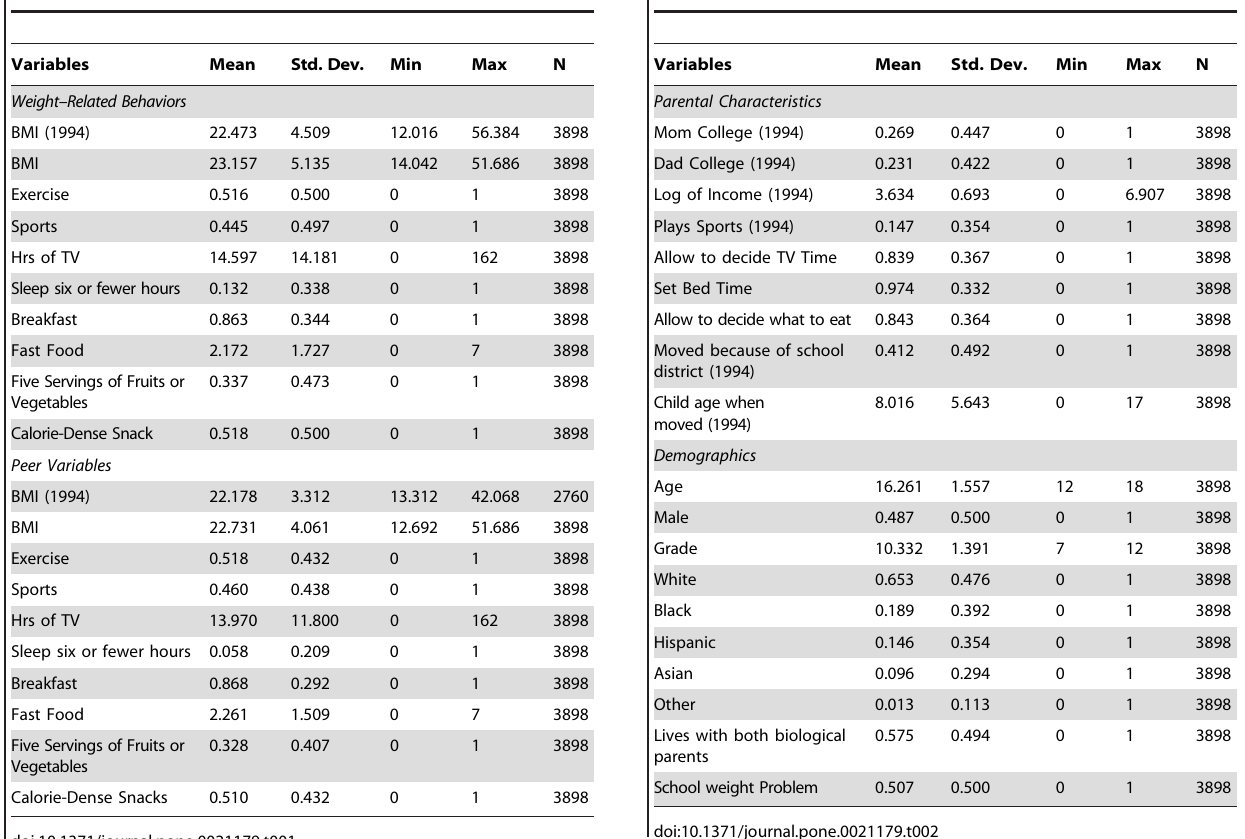
Table 2. Descriptive Statistics (Adolescents from Add Health Wave